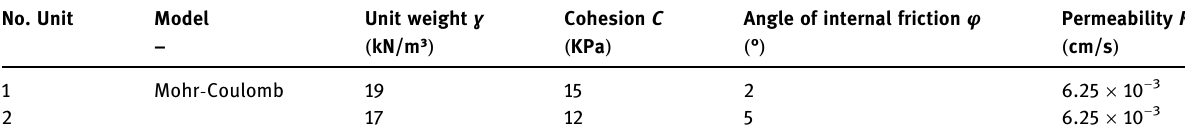
Table 1: Earth canal material properties after rationing system No. Unit